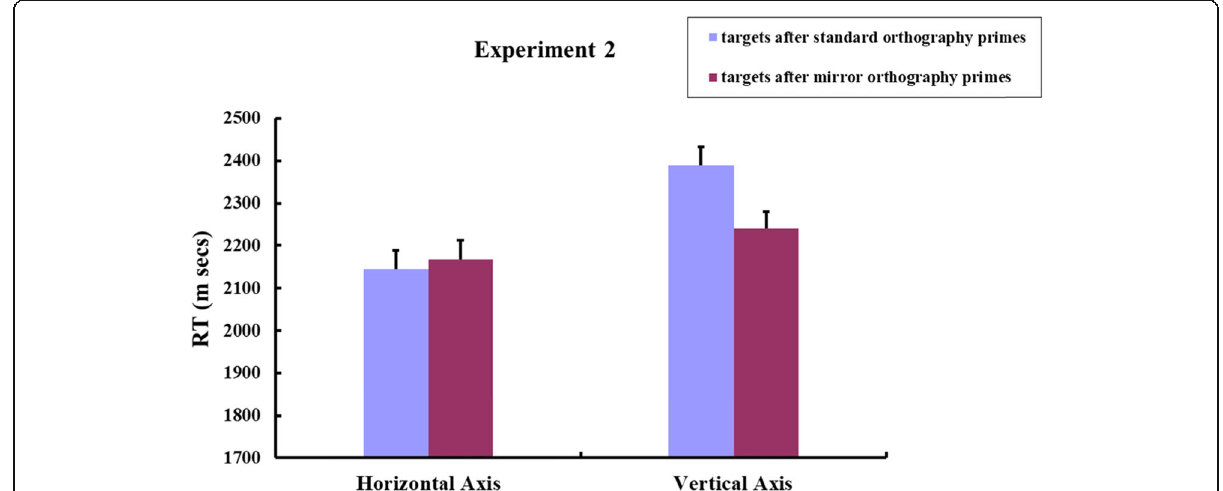
Fig. 8 Experiment 2: Mean RTs for targets after the horizontal standard-orthography/mirror-orthography primes and the vertical standard- orthography/mirror-orthography primes by Japanese speakers. The figure plotted by participants ’ mean RTs. Error bars indicate standard errors of the